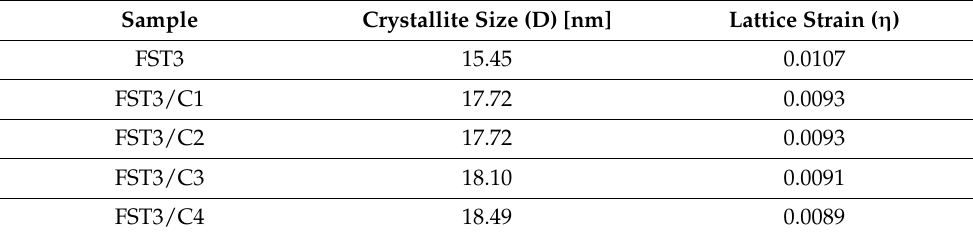
Table 2. Crystallite size and lattice strain for different MWCNT loading on anatase TiO 2 .